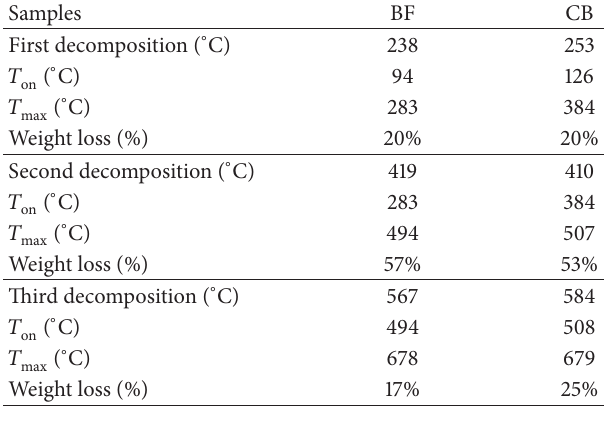
Table 1: Thermal property of BF and CB samples.